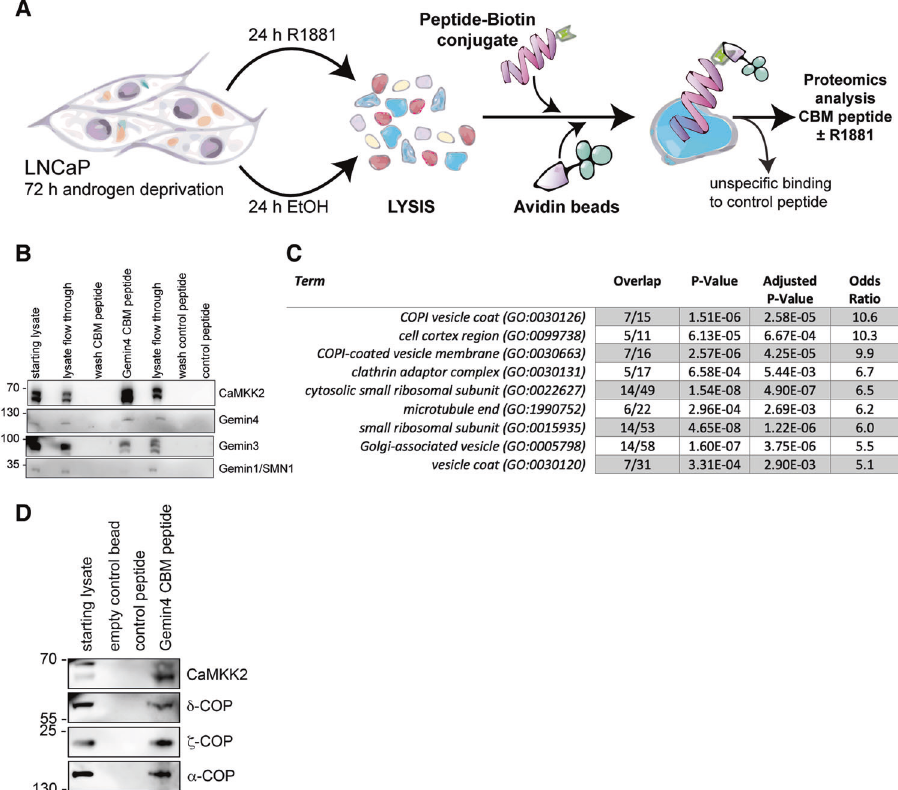
Fig. 2 Identi fi cation of the COPI coat complex as a novel interaction partner of the CaMKK2-Gemin4 protein complex. A A schematic outlining the Gemin4 peptide pulldown experiment using biotinylated CaMKK2-binding motif (CBM) as bait from cell lysates of LNCaP cells treated with androgen (R1881) or an ethanol control. Bound proteins were identi fi ed by western blotting or mass spectrometry. B The streptavidin pulldown of biotinylated Gemin4 CBM and control peptide was analysed by western blotting to demonstrate enrichment of known interactors CaMKK2 and Gemin proteins. C Proteins that bound speci fi cally to the Gemin4 CBM peptide were identi fi ed with mass spectrometry and the data set was assessed by pathway analysis (GO cellular location). The top ranked pathways are shown in a table. D A Gemin4 CBM peptide pulldown was used to validate the novel interactions of Gemin4 identi fi ed by the pathway analysis. Proteins bound by the peptide from LNCaP cell extract was analysed by western blot using antibodies for CaMKK2 and three components of the COPI complex; α -COP, δ -COP and ζ